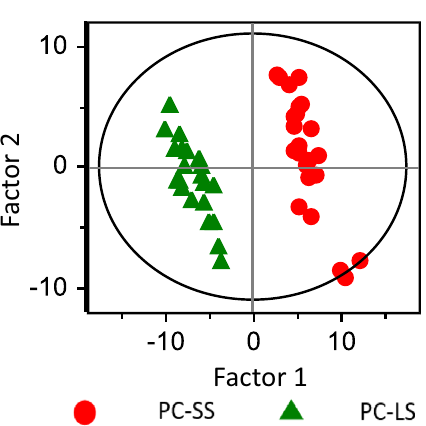
Figure 2. Plot prepared using FID STFT data obtained from patients with pancreatic cancer comparing long- term survivors (LS) and short-term survivors (SS). Green triangles represent patients surviving over 2 years (LS) and red closed circles represent patients surviving less than 2 years (SS) ( R 2 = 0.989 and Q 2 =